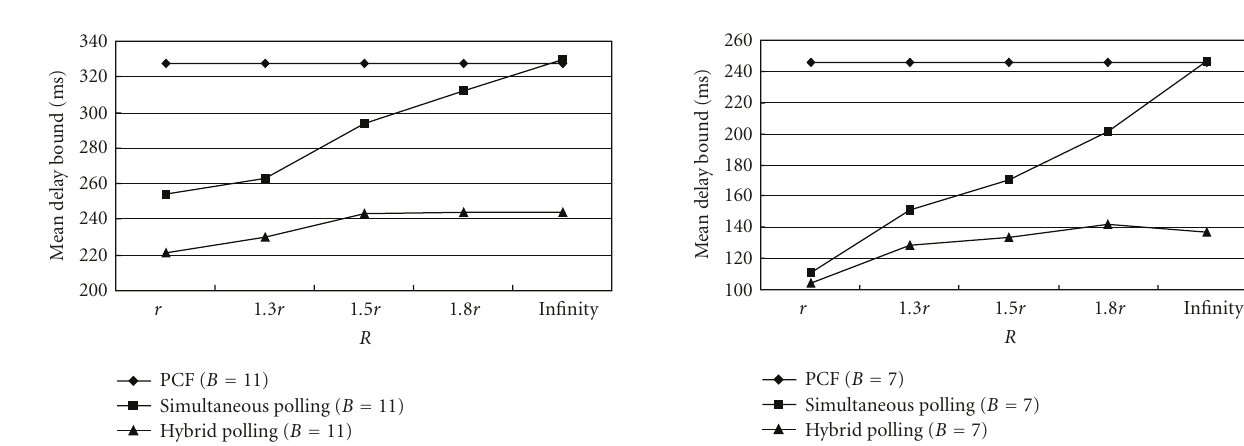
Figure 6: Mean delay bounds when the heavy tra ffi c load ( B = 11) is imposed on IEEE 802.11a wireless LAN with 20 STAs.